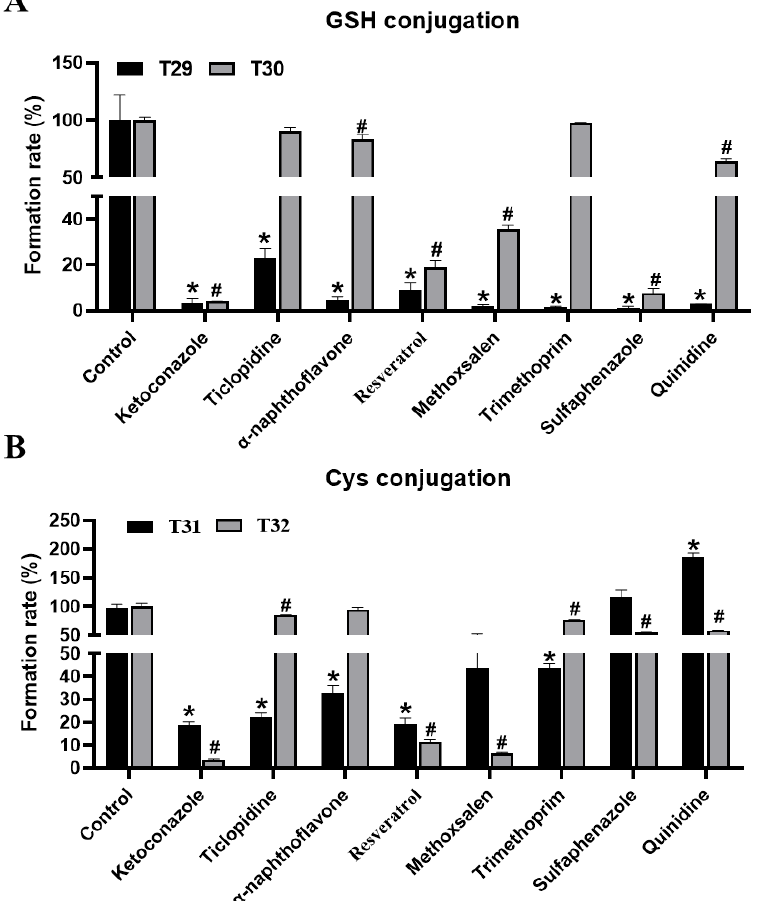
Figure 6. Inhibitory effects of CYP inhibitors on the formation of T29–T32 in MLM incubation systems. ( A ) Inhibitory effects of CYP inhibitors on the formation of T29 and T30 metabolites in MLM incubation systems. ( B ) Inhibitory effects of CYP inhibitors on the formation of T31 and T32 metabolites in MLM incubations systems. The relative level of abundance of each metabolite during the incubation in the MLM system without inhibitors was 100%. All the data are expressed as a mean ± SD ( n = 3). Two group comparisons between the positive control (incubated with the parent compound without a CYP inhibitor) and each group of samples with the co-incubation of the CYP inhibitor and the parent compound was conducted using a Student’s independent t-test, followed by multiple testing corrections. * p < 0.05 represents the control (T29, T31) vs. other groups; # p < 0.05 represents the control (T30, T32) vs. other